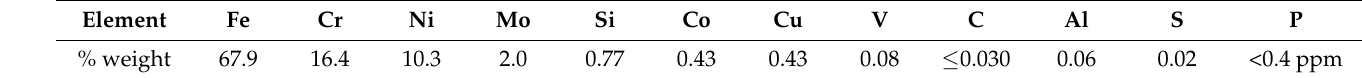
Table 2. Chemical composition 316L stainless steel.